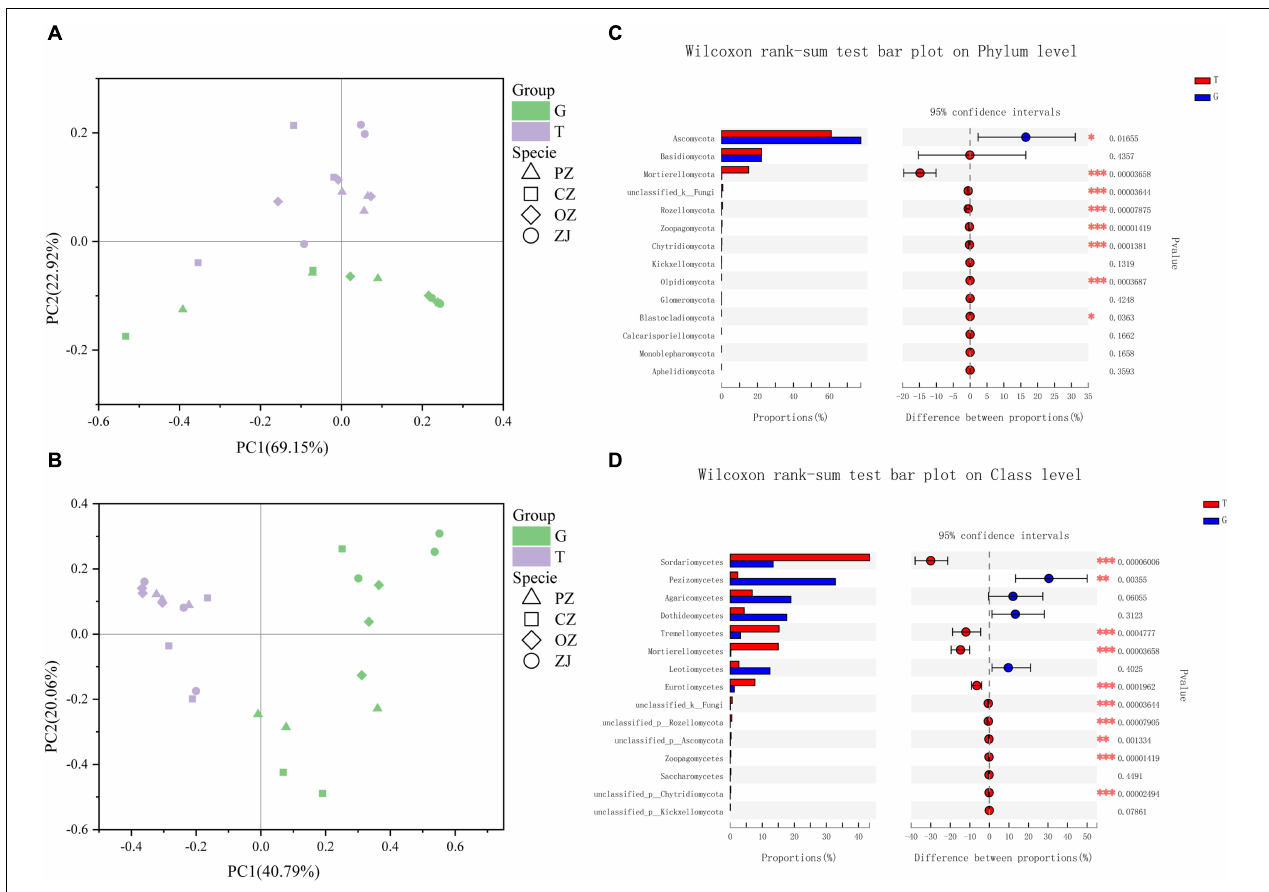
FIGURE 2 | Principal co-ordinates analysis of the rhizosphere soil (T) and root endospheres (G) at the phyla level (A) and class level (B) ; extended error bar plot showing the fifteen most abundant phyla and classes that had significant differences between root endospheres and rhizosphere soil (C,D) . Positive differences in mean relative abundance indicate phyla or classes overrepresented on the root endospheres (G), while negative differences indicate phyla or classes greater abundance in the rhizosphere soil (T). * P < 0 . 05; ** P < 0 . 01; *** P < 0 . 001.